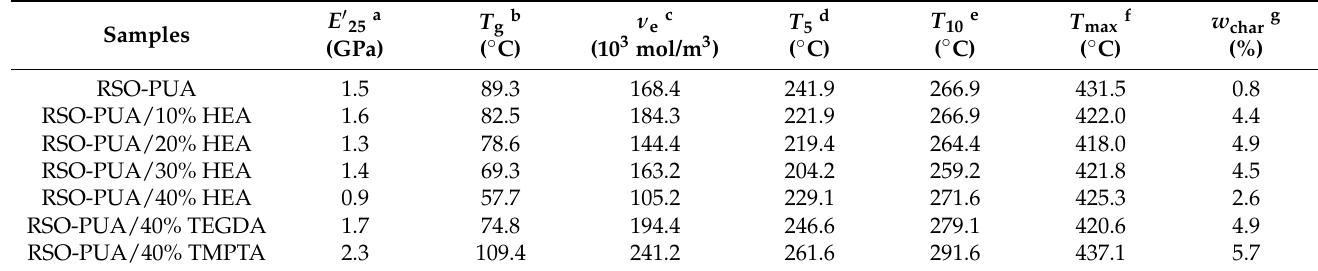
Table 2. Thermal properties of the cured RSO-PUA resins.